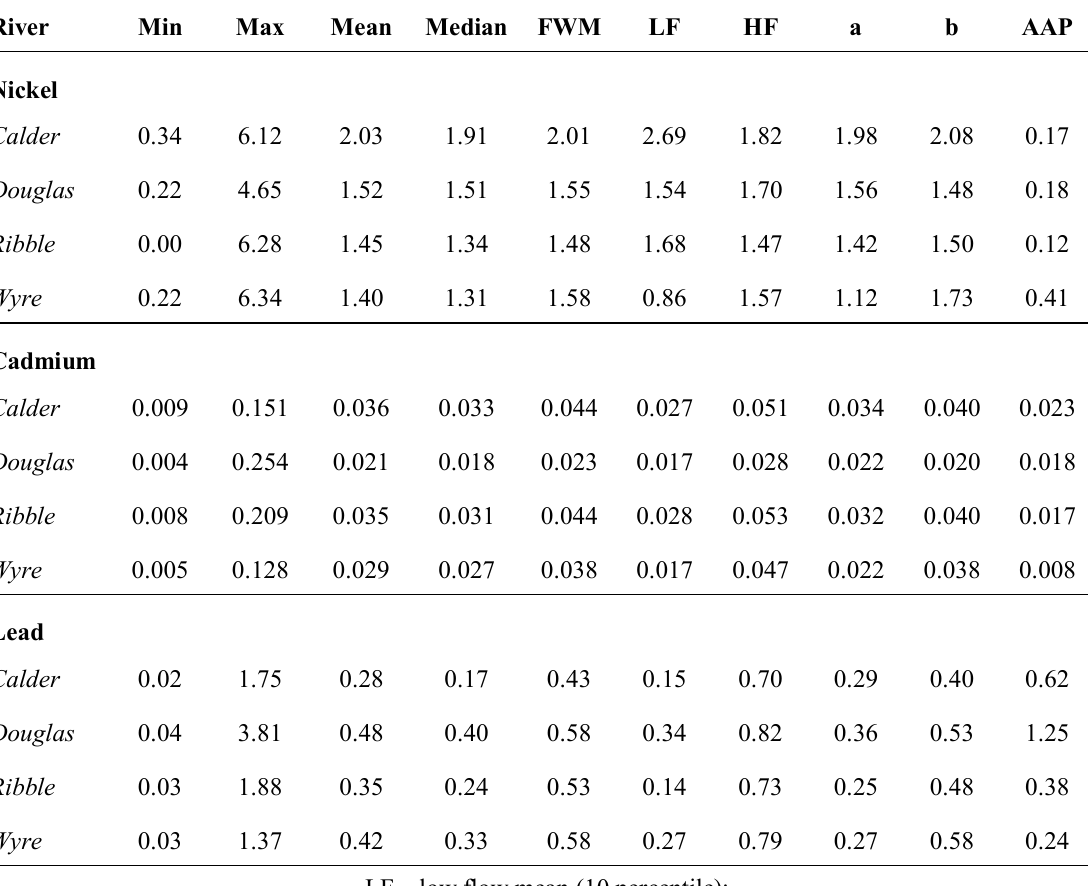
Table 2. Summary data (n = 42) for dissolved Ni, Cd and Pb for each river catchment (µg L −1 ).